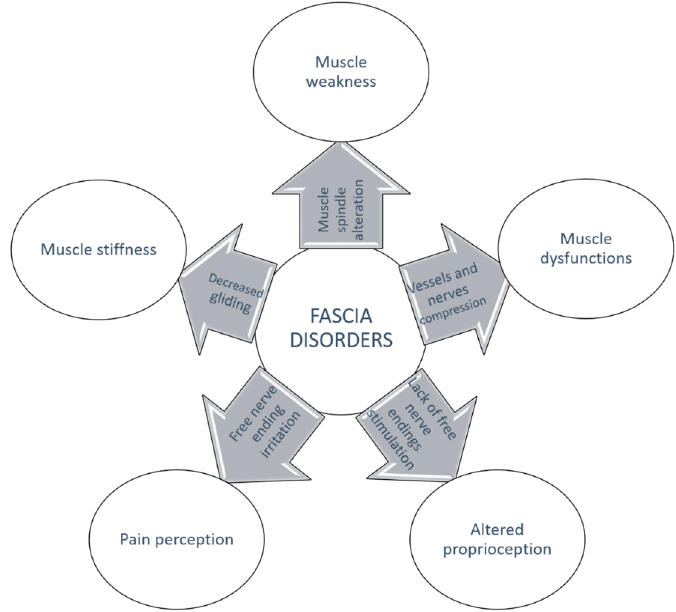
Figure 3. Any alteration affecting one of the interconnected elements of the MFU is at the basis of fascia disorders.